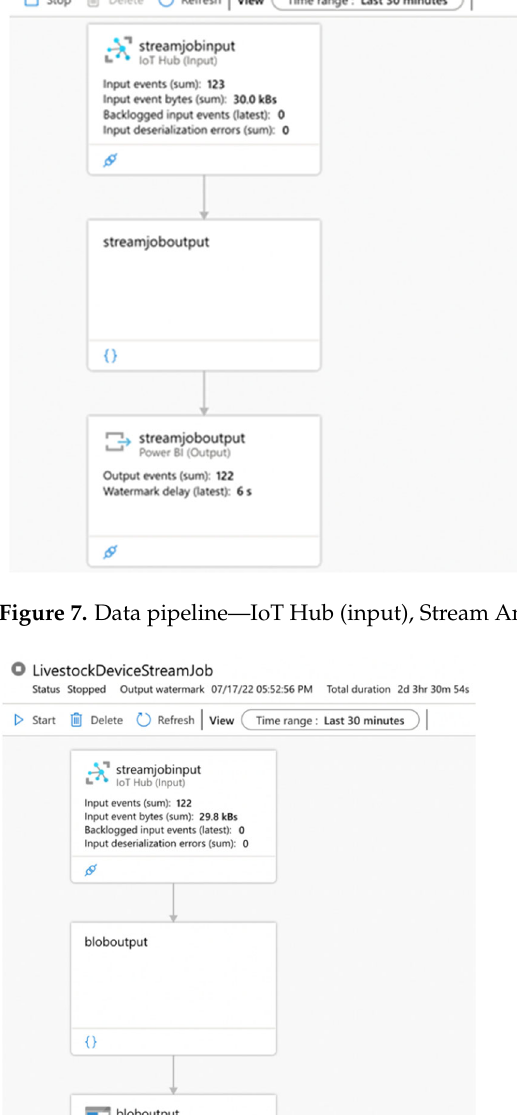
Figure 7. Data pipeline—IoT Hub (input), Stream Analytic Job (query), Power BI (output).